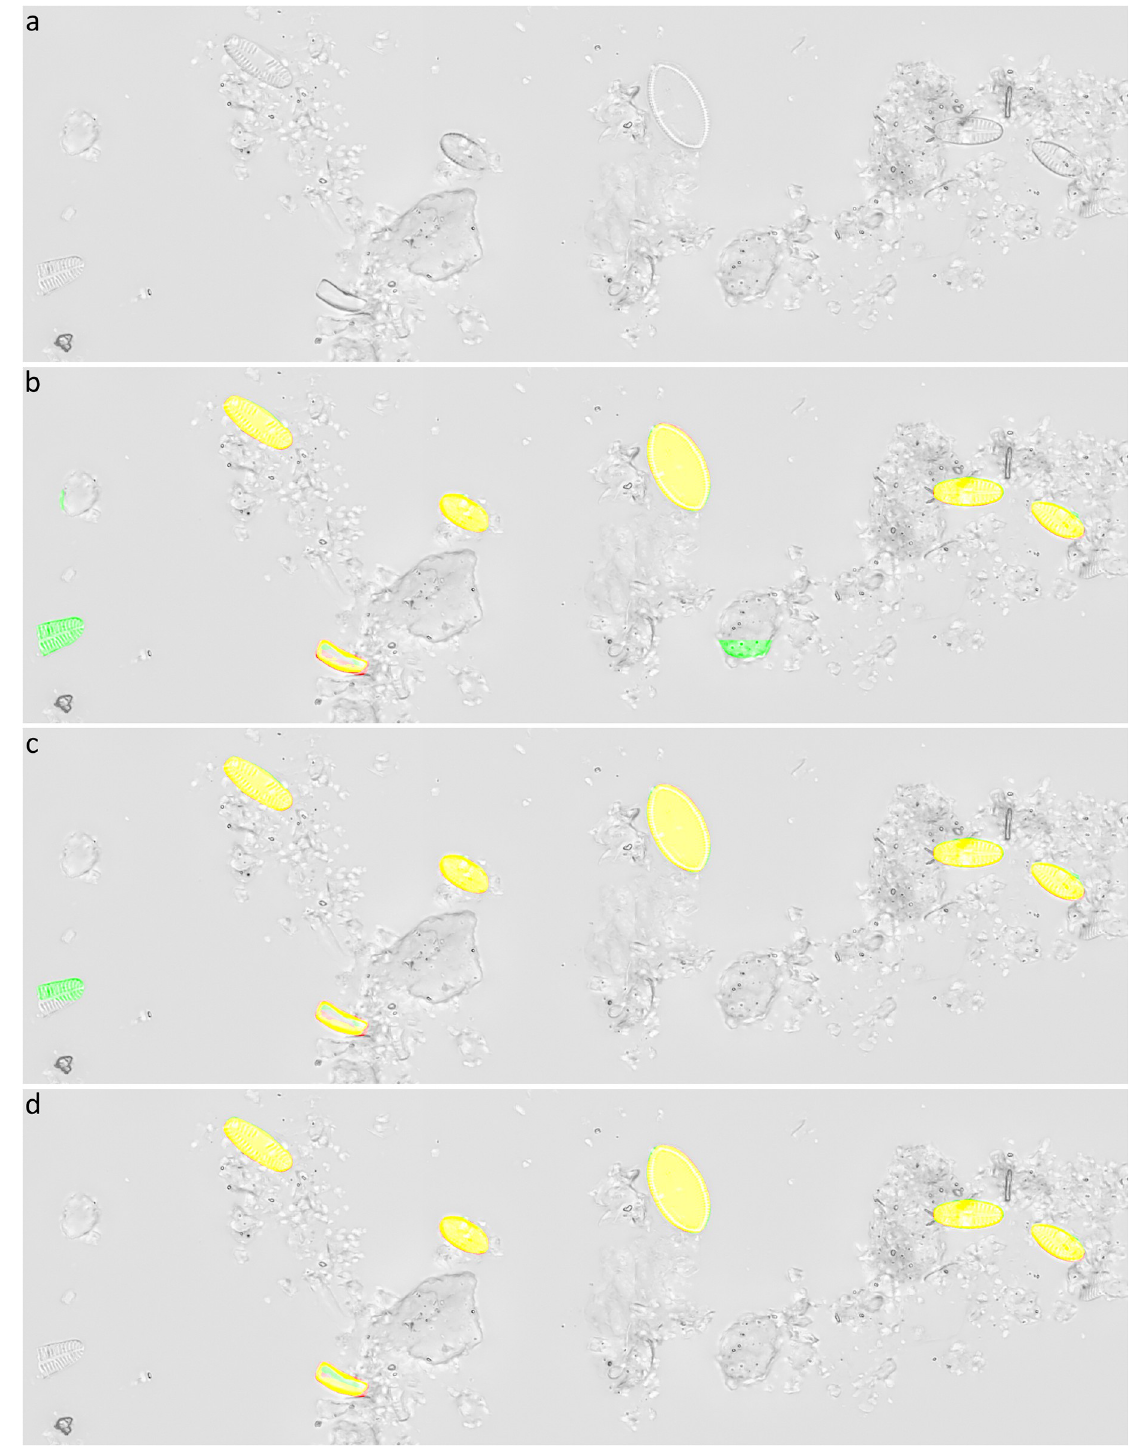
Fig 8. Typical segmentation results of Mask R-CNN models trained on 100% training data, with a prediction score threshold of 0.95. a) Input data, b) segmentation result for fixed-stride training data, c) segmentation result for object-based training data, d) segmentation result for training data generated by object-based positioning + object integrity constraint. Yellow = true positive, red = false negative, green = false positive.